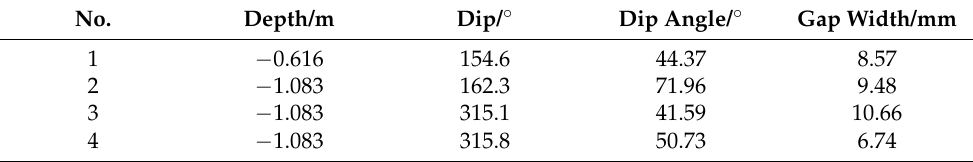
Figure 7. Fine recognition results for Figure 3a. Table 2. Fine recognition data for the structural planes in the borehole images shown in Figure 5.